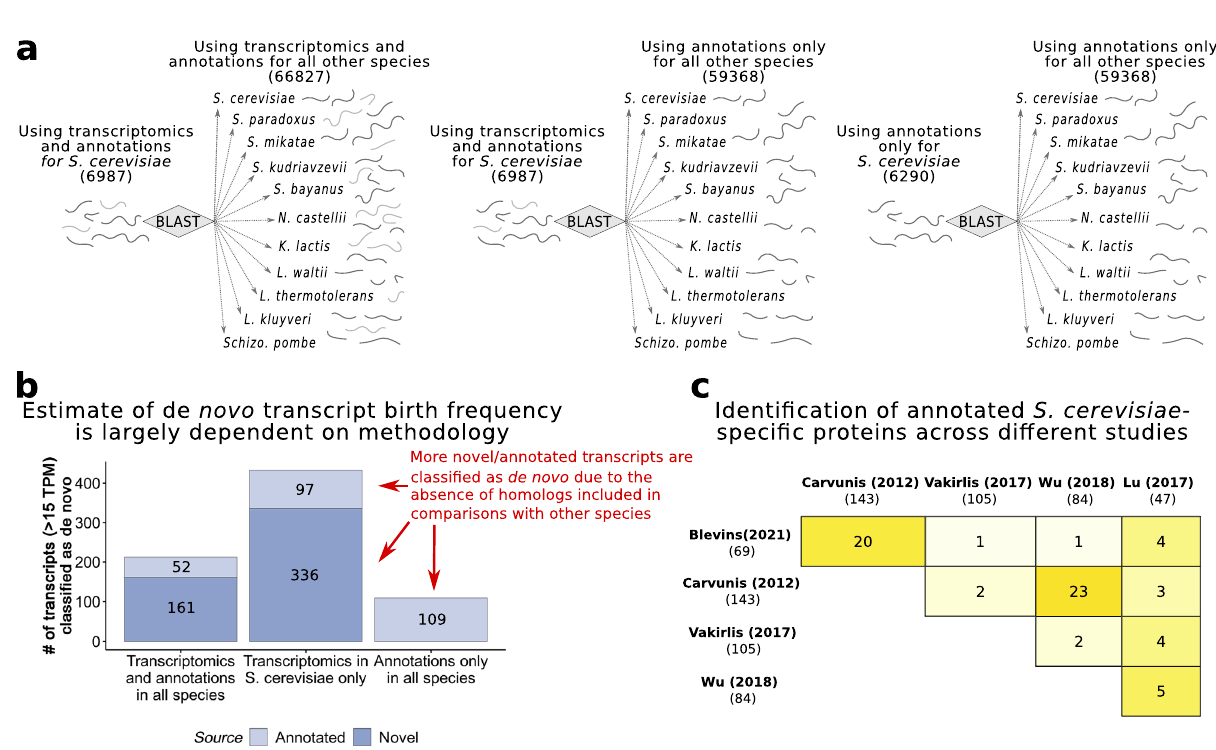
Fig. 3 Identi fi cation of de novo transcripts using different approaches. a Diagram representing different strategies depending on the use of annotations or transcriptomics data. The use of transcriptomics data to obtain de novo assembled, non-annotated, transcripts, increases the scope of the comparisons of expressed sequences across species. b Number of de novo transcripts identi fi ed with each of the approaches. The same computational pipeline was applied in all cases, the only differences was whether we used transcriptomics (de novo assembled transcripts) and annotations in all species (our approach), transcriptomics only in the reference species, or annotations only. Many more de novo transcripts were retrieved in the other approaches. c Comparison of annotated S. cerevisiae -speci fi c de novo proteins that are common between different previously published studies and this study. We used overlap in the genomic coordinates to categorize two transcripts or ORFs as common between two studies. We see moderate overlap in the pairwise comparisons, no two methods have produced very similar results. Note that when several lists existed for the same study we took the least stringent one. Source data are provided as a Source Data fi